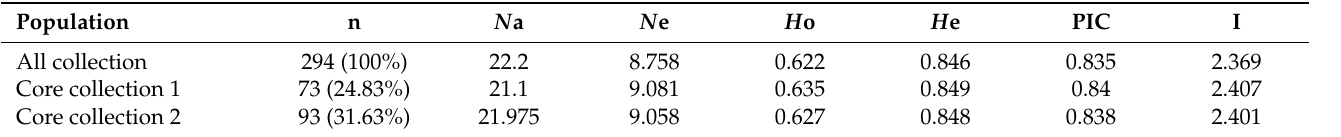
Table 5. Comparison of genetic diversity among all collections, core collection, and remaining